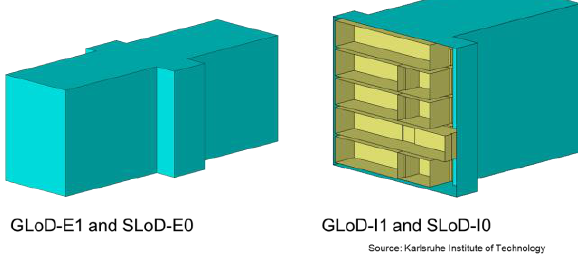
Figure 14: Building exterior and interior as GLoD-E1/GLoD-I1 solids